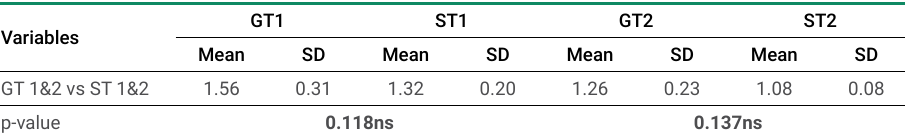
Table 3. Mean and standard deviation (SD) values of GT 1&2 vs ST 1&2